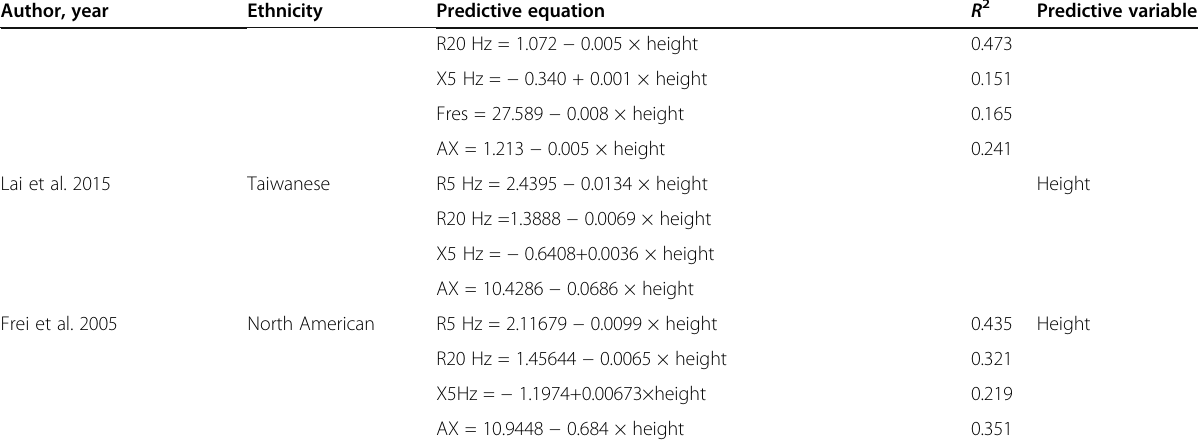
Table 6 Summary of the predictive equation of impulse oscillometry in different ethnicities (Continued) Author,